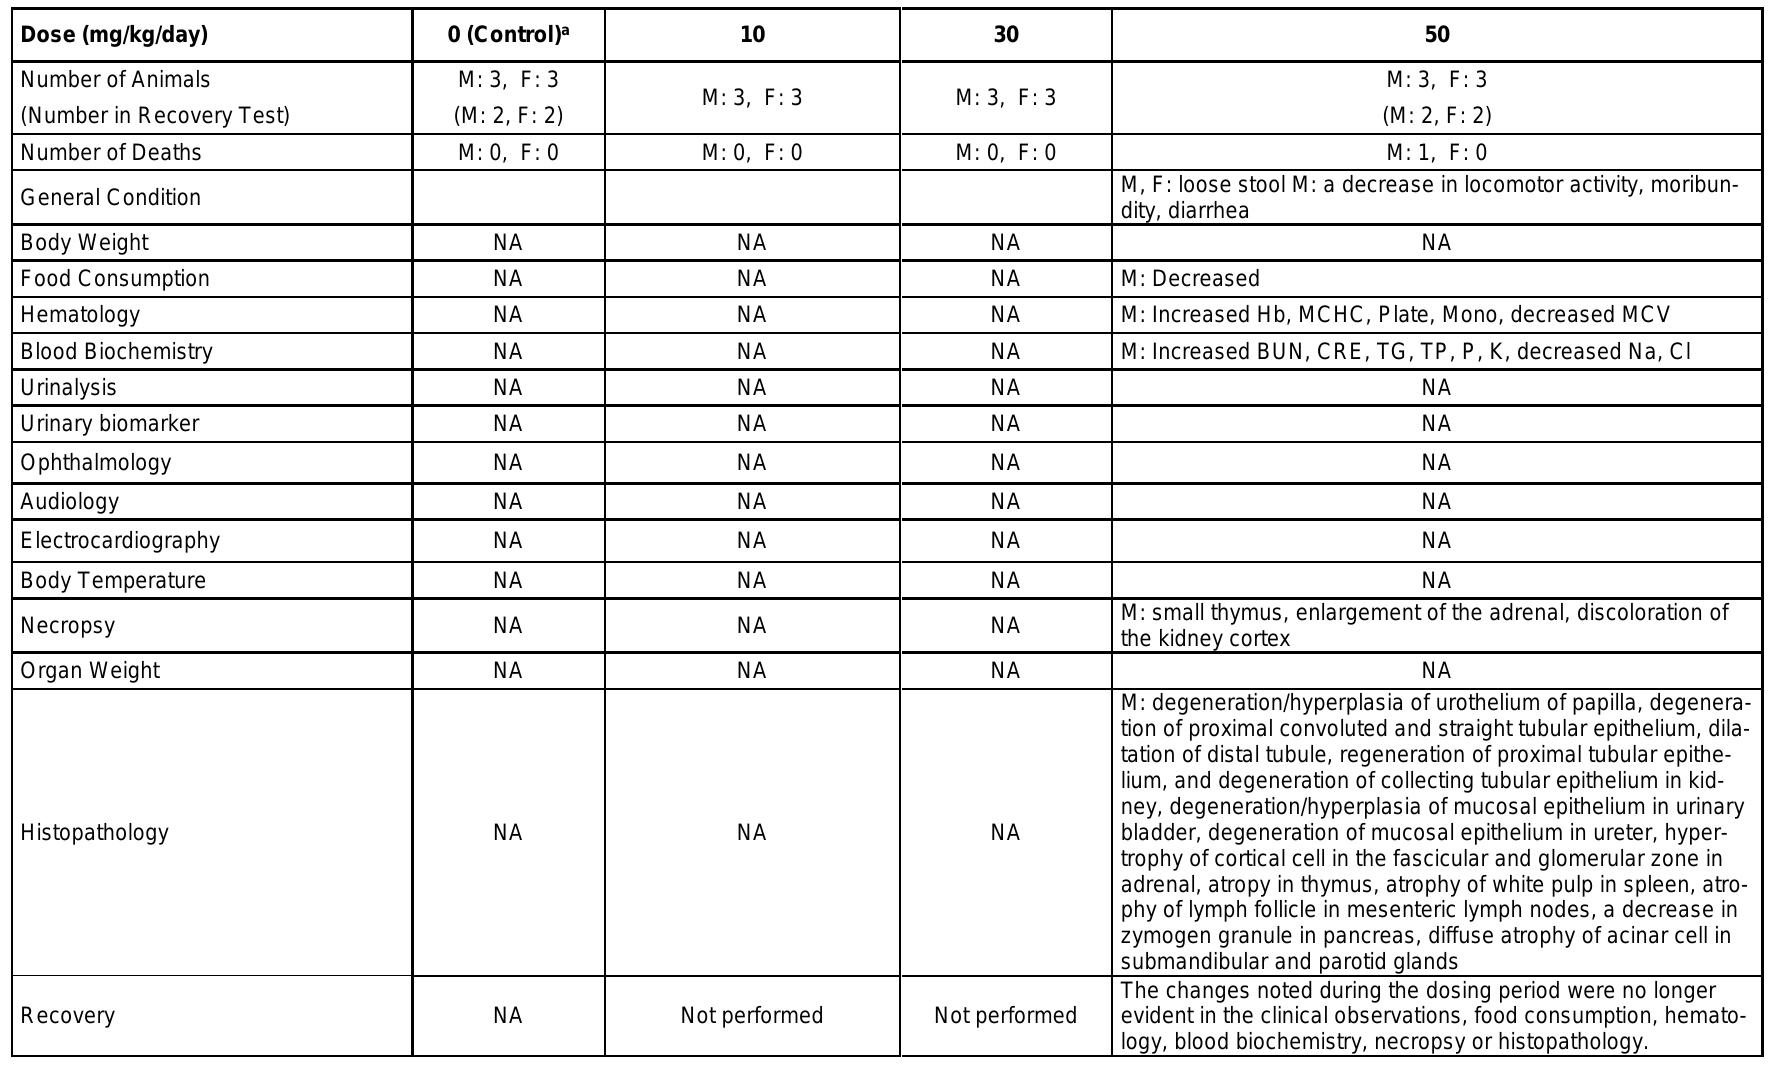
Table 4: Four-week repeated-dose oral toxicity study in monkeys with 4-week recovery test Dose (mg/kg/day)